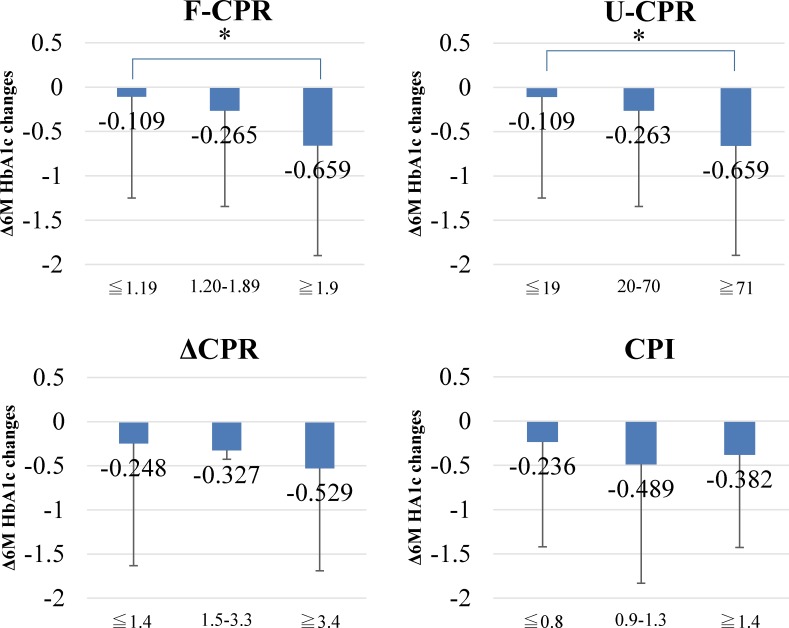
Relationship between HbA1c changes and four indices of insulin secretion.Subjects were stratified by the tertiles of four indices of insulin secretion such as F-CPR, U-CPR, ΔCPR, and CPI, and HbA1c changes were compared high and mid tertiles with lowest insulinogenic tertile as standard. *, p < 0.05 by ANOVA and post-hoc Dunnett’s test.